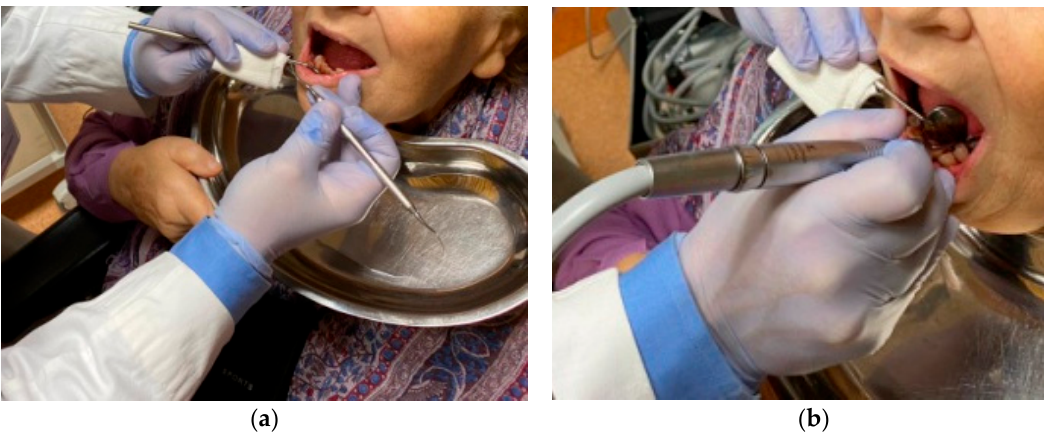
Figure 3. ( a ) Gingival probing; ( b ) Working phase with use of portable unit tool.